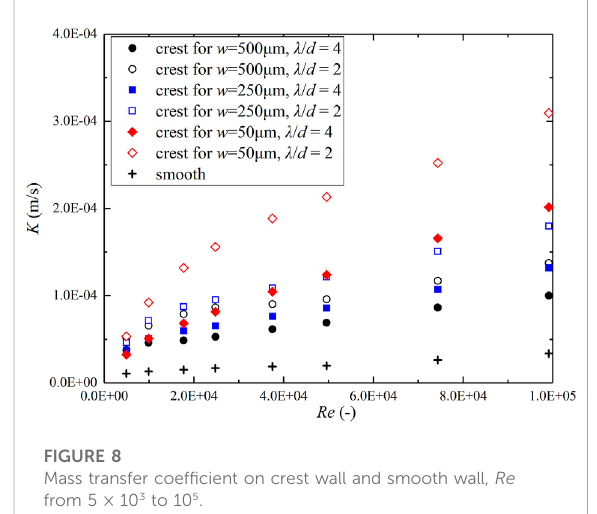
FIGURE 10 Distribution of turbulent kinetic energy on the crest wall ( d = 500 μ